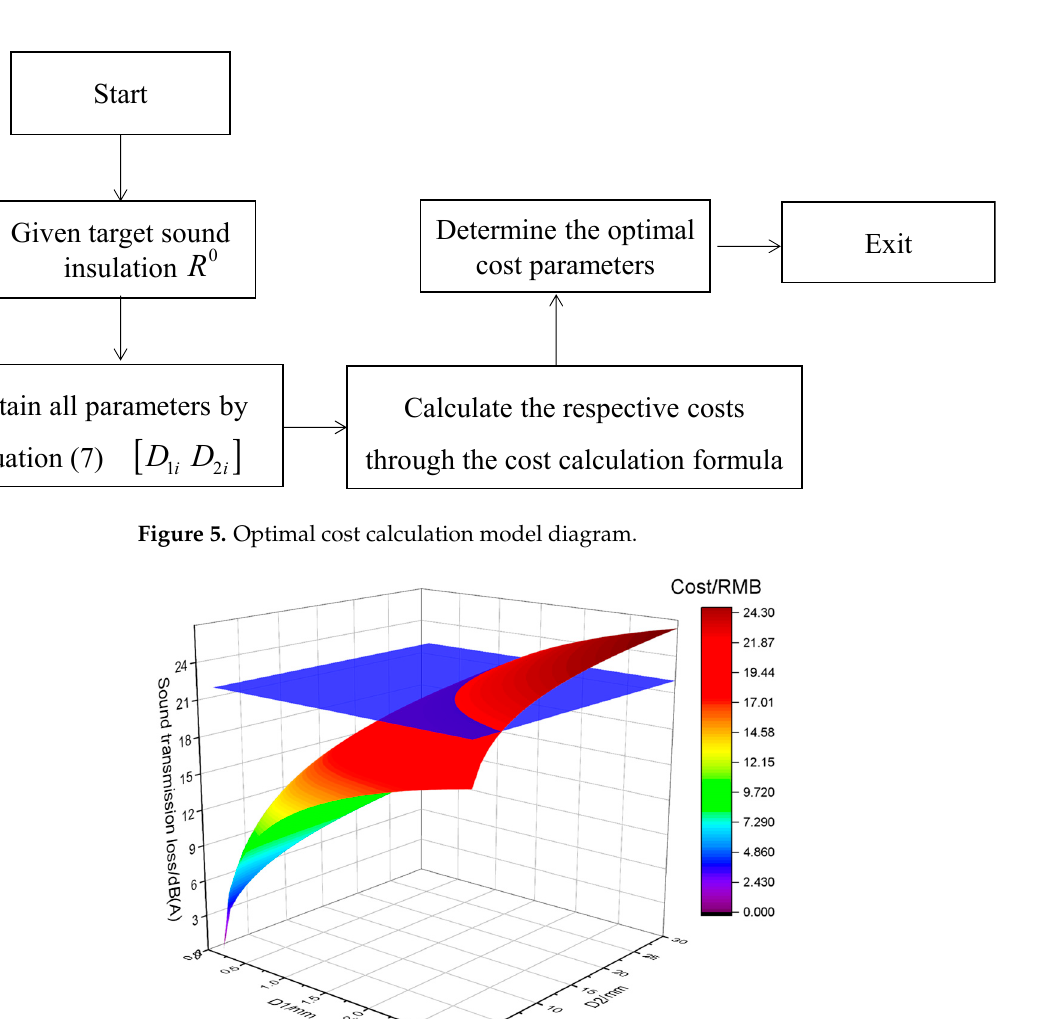
Figure 6. Parameter combinations meeting the sound insulation conditions (3D